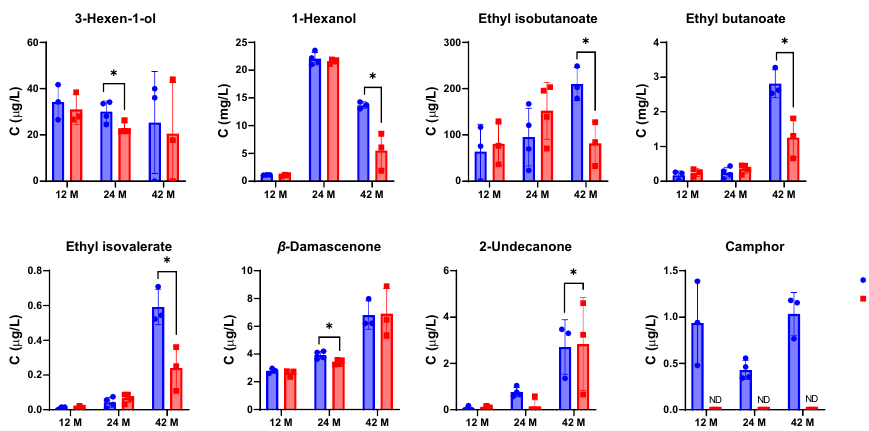
Figure 1. Bar graphs representing the levels of volatile compounds significantly changing in sparkling wine #1 sealed with a sparkling cork with two natural cork discs (2D in blue) and a microagglomerated cork (MA in red) during bottle aging (12 to 42 months). *– p ≤ 0.05 , ND–not detected.